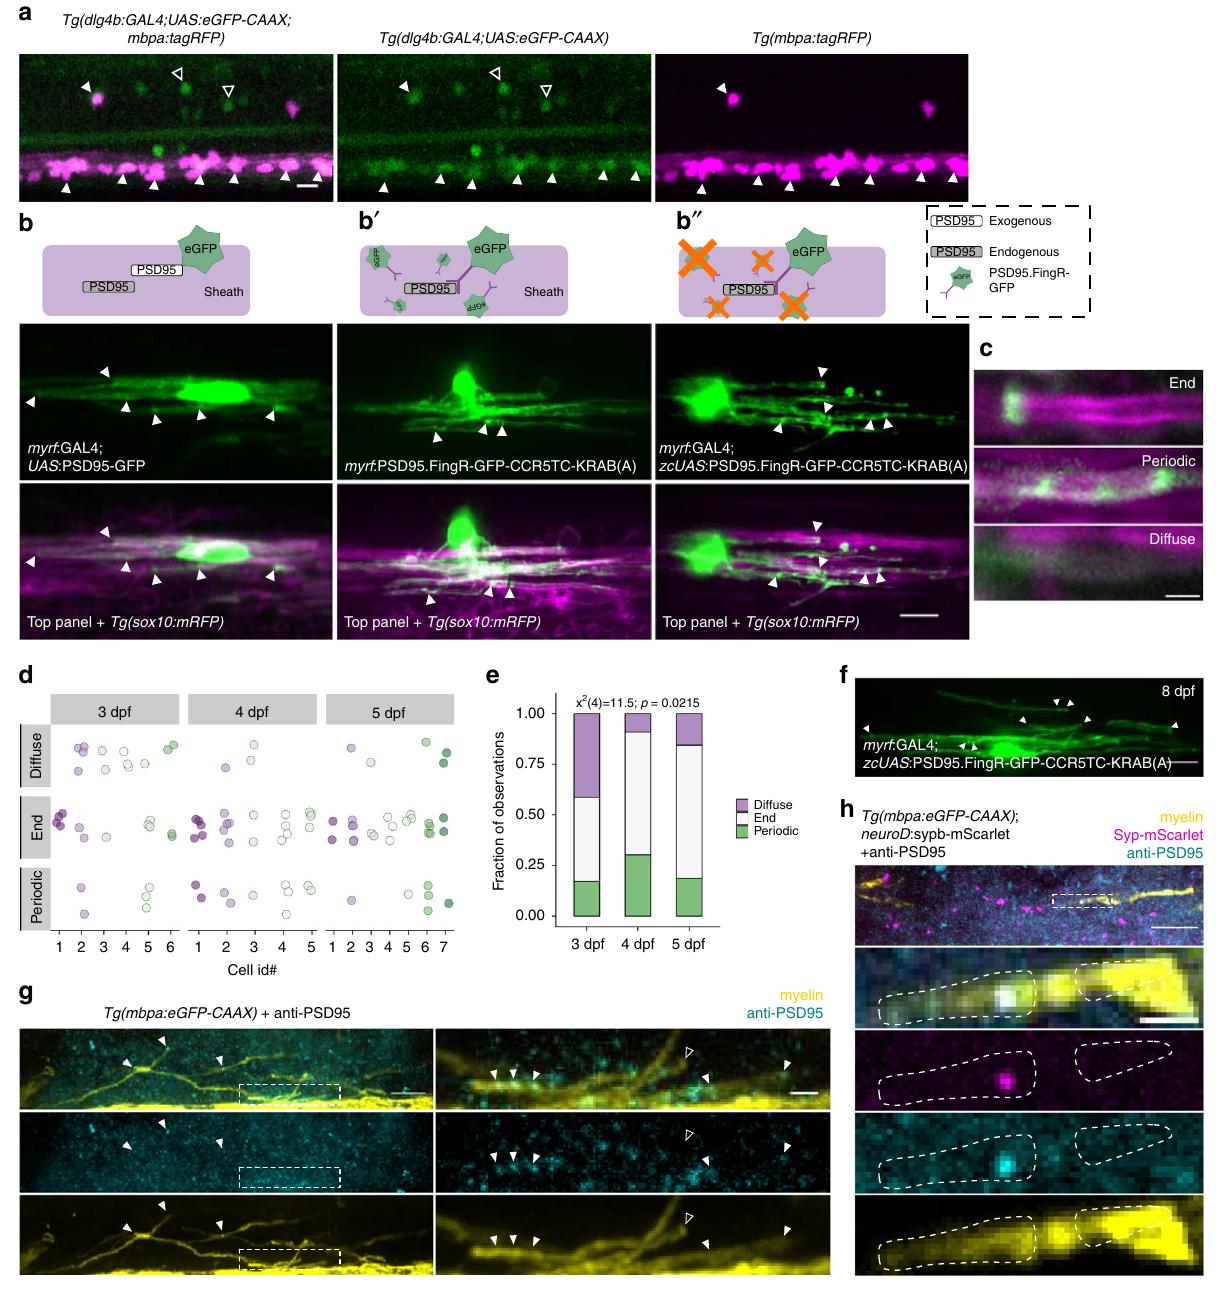
Fig. 3 PSD95 is expressed by myelinating oligodendrocytes and is variably localized within myelin sheaths. a CRISPR/Cas9-mediated GAL4 enhancer trap of dlg4b reports spinal cord cells that express dlg4b via UAS :eGFP-CAAX expression. Larvae additionally carrying the mbpa:tagRFP transgene reveal mbp + myelinating oligodendrocytes. Closed arrowheads indicate mbp + , dlg4b + oligodendrocytes and open arrowheads indicate mbp-, dlg4b + cells. Scale bar, 10 µ m. b , b ′ , b ″ ) PSD95 localization within oligodendrocytes detected by expression of exogenous PSD95-GFP fusion protein ( b ), expression of PSD95. FingR to detect endogenous PSD95 localization ( b ′ ), and expression of PSD95.FingR to detect endogenous PSD95 localization with a transcriptional repression system to limit unbound PSD95.FingR-GFP ( b ″ ). Arrowheads indicate puncta, scale bar 10 µ m. c Expression of the transcriptionally-regulated system ( b ″ ) with Tg(sox10:mRFP) to label myelin shows that not all sheaths display localized PSD95 puncta ( “ diffuse ” ), and among those that do, labeling is either restricted to the sheath end ( “ end ” ), or periodic along the length of the sheath ( “ periodic ” ). Scale bar, 2 µ m. d Classi fi cation plot of sheath labeling patterns (y-axis) for individual cells (x-axis) at 3, 4, and 5 dpf. n = 6 cells/29 sheaths (3 dpf); 5 cells/33 sheaths (4 dpf); 7 cells/32 sheaths (5 dpf). For each age group, dots of the same color denote sheaths belonging to the same cell. Note that most cells formed sheaths with different labeling patterns. Over developmental time, the distribution of labeling patterns changes as assessed by Chi square test ( e ), notably with a reduction of diffuse labeled sheaths, but all three categories persist at 5 dpf. ( f ) Later in development (8 dpf), PSD95.FingR-GFP is less punctate overall but remains enriched at the ends of sheaths (arrowheads). g Sagittal section of a 5 dpf Tg(mbpa:eGFP-CAAX) larva spinal cord fi xed and immunolabeled with anti-PSD95. Right panels show higher magni fi cation of the boxed region. Arrowheads indicate PSD95 signal colocalized with sheaths; open arrowhead marks a sheath without PSD95 at the terminal end. h Similar to g but with transient expression of neuroD :sypb-mScarlet to sparsely label synaptic vesicle puncta. Inset shows colocalized PSD95 and Syp-mScarlet within a sheath. Scale bars are 10 µ m and 2 µ m